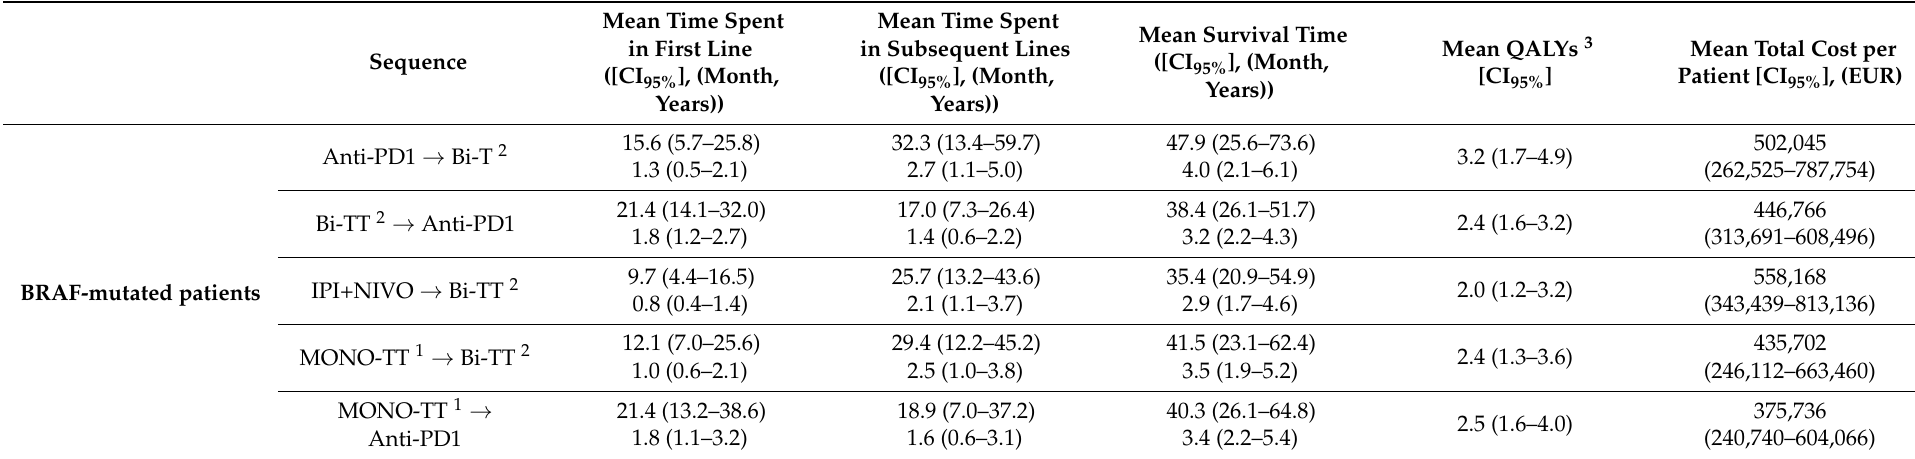
Table 3. Mean time spent in first and subsequent line of treatment, survival time, QALY, and total cost per patient from the multistate model (MSM) at 10